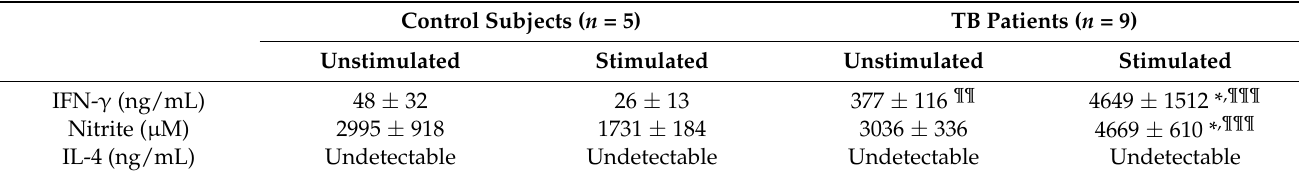
Table 2. IFN- γ and nitrite levels from the alveolar macrophages of patients with active TB and non-TB subjects.